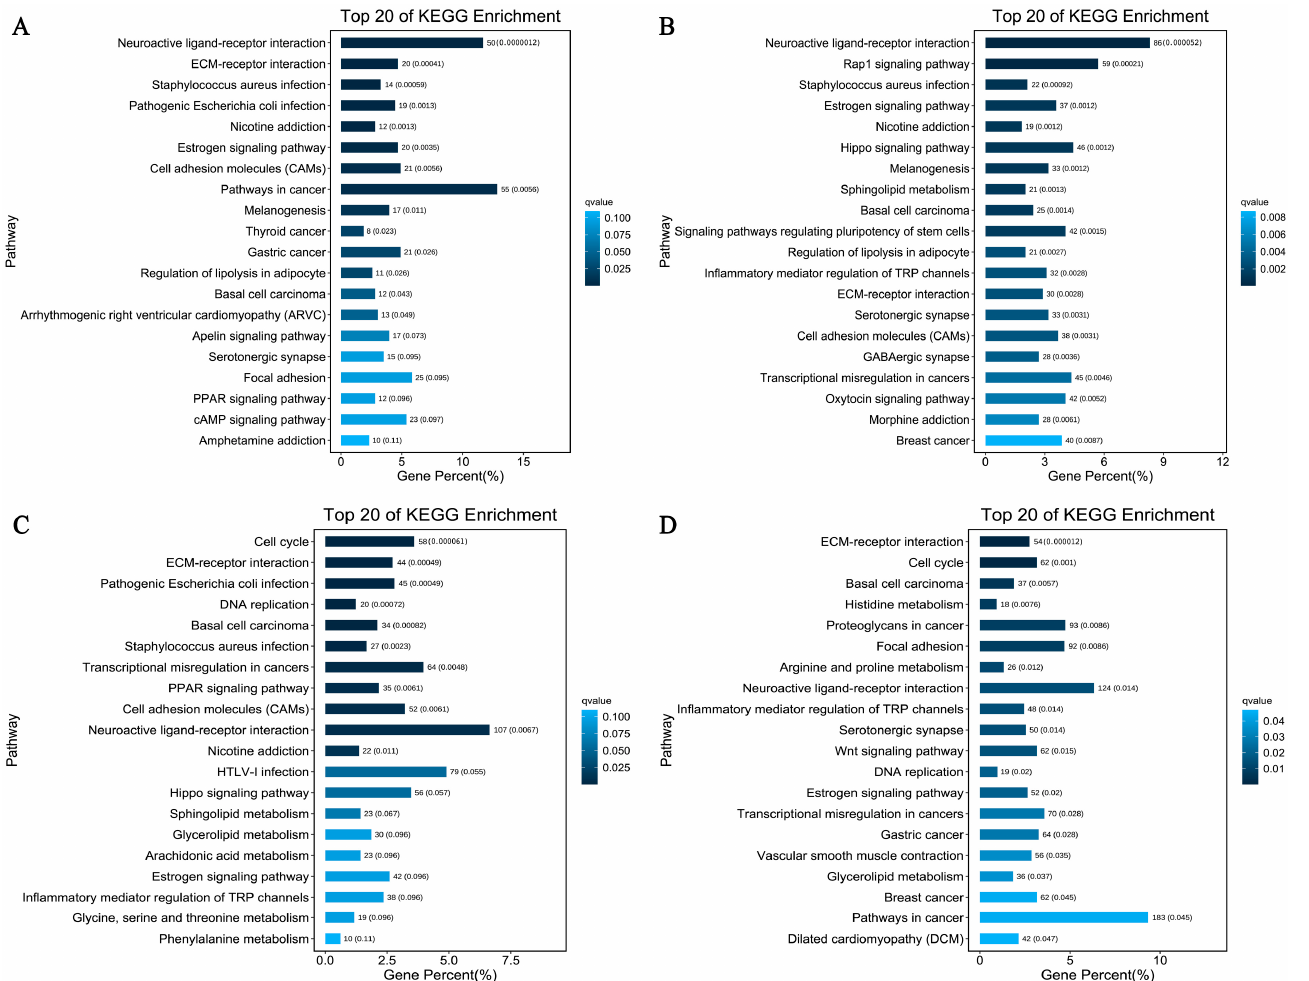
Figure 4. KEGG analysis of genetic differences in skin and feather follicle development in Zhedong white geese. ( A – D ) shows the comparison group of E13, E18, E23, and E28 with E10. The abscissa represents the number of enriched genes, and the ordinates represent signal pathways.